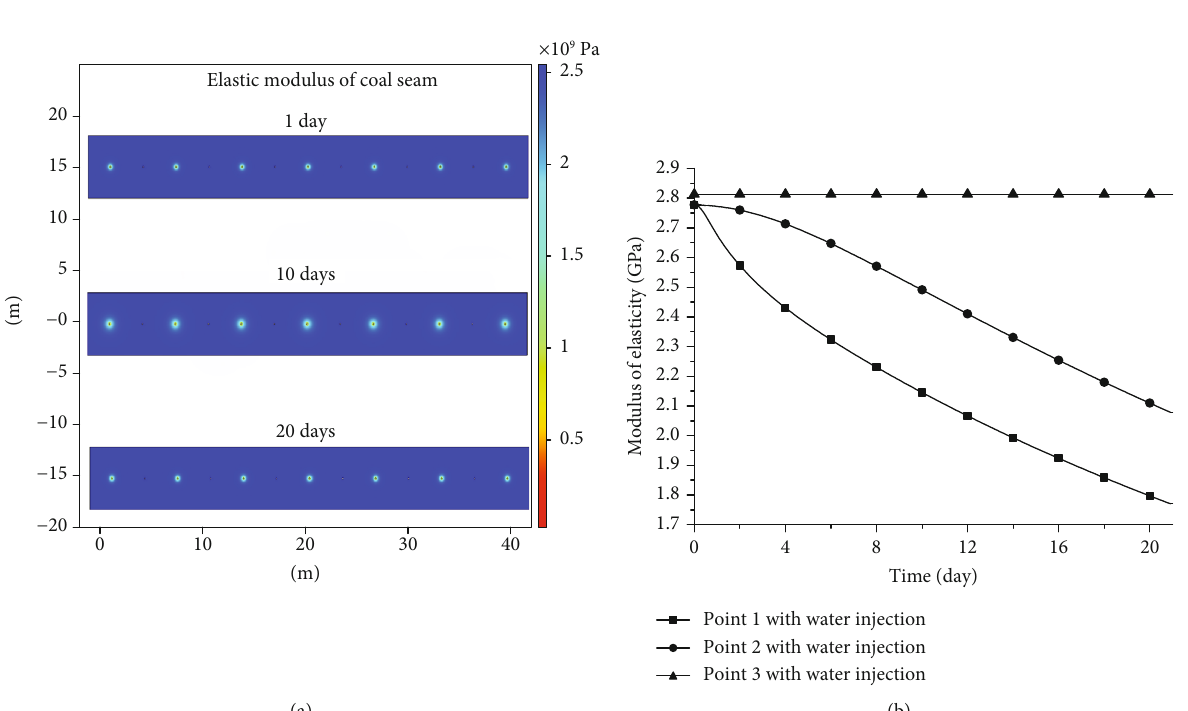
Figure 7: Elastic modulus changes ((a) contour map; (b) elastic modulus